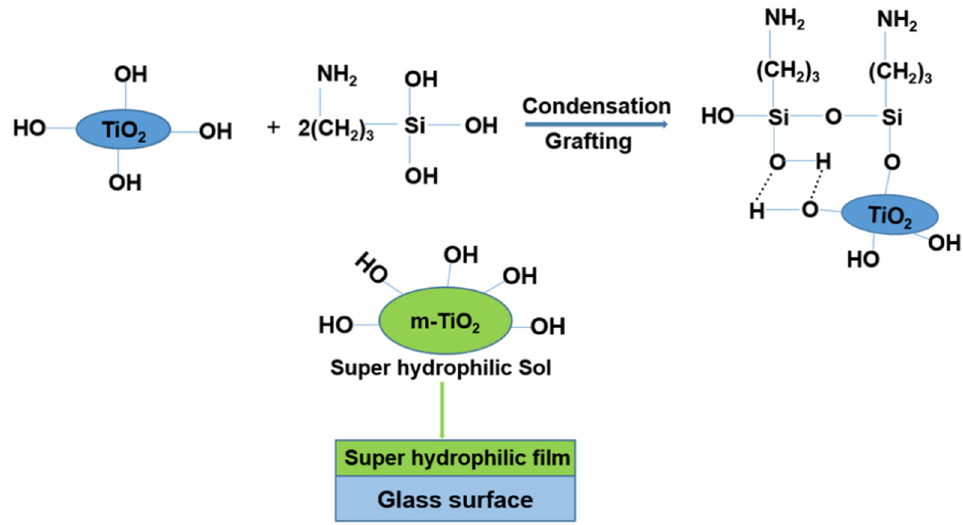
Figure 1. Surface modification of TiO 2 with (3-aminopropyl) triethoxysilane (KH550) and the modified TiO 2 (m-TiO 2 ) super-hydrophilic film on a glass substrate.